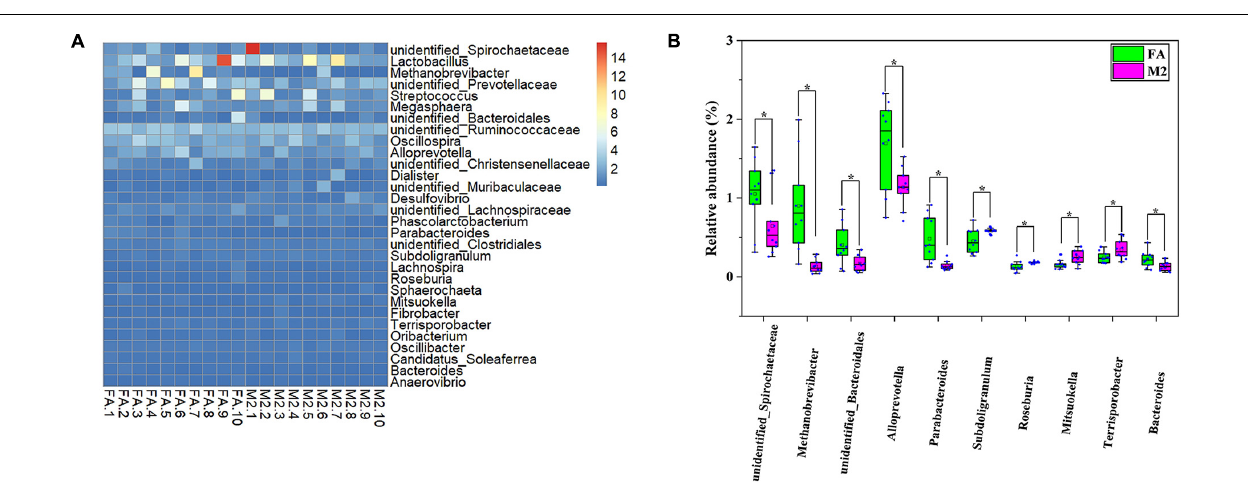
Frontiers in Microbiology |